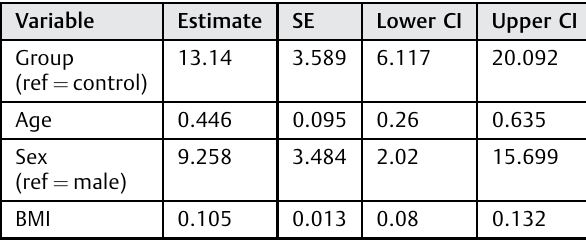
Table 2 Bayesian path analysis output to investigatethe effect of intervention, age, gender, and BMI on immobilization duration